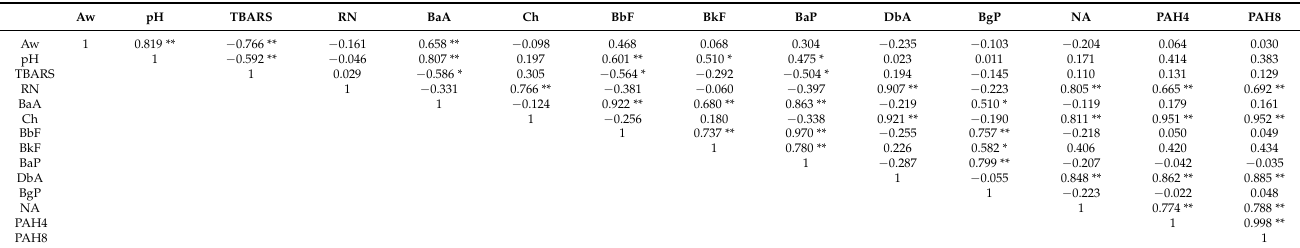
Table 5. Correlation between Aw, pH, TBARS, residual nitrites, BaA, Ch, BbF, BkF, BaP, DbA, BgP, NA, PAH4 and PAH8 in Larou of artisanal and industrial